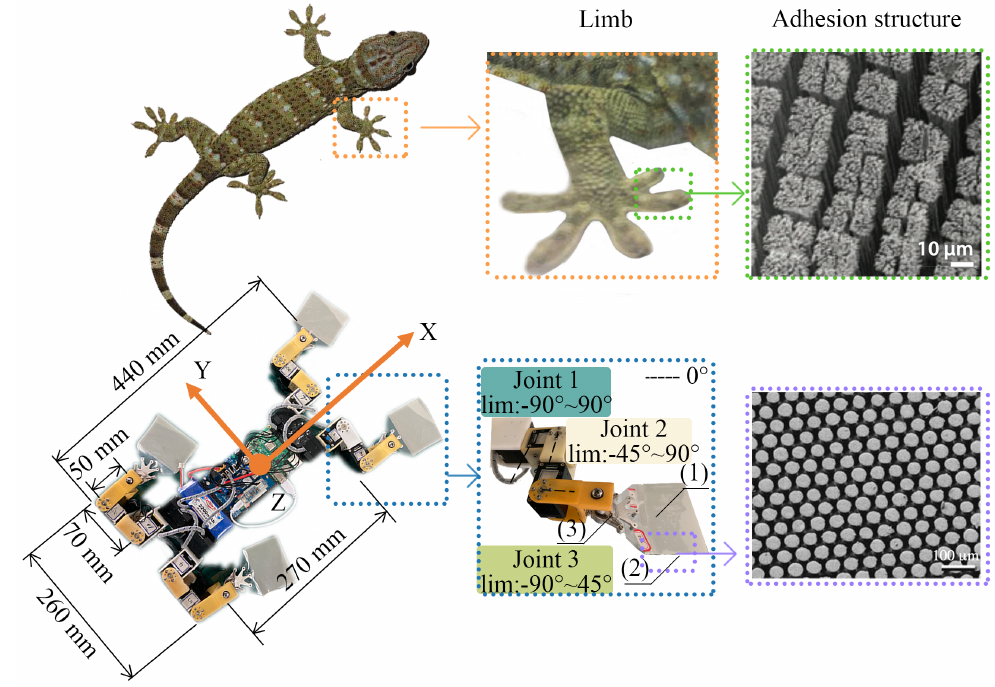
Figure 3. Bionic structure design of IBSS–8 for the body, limb, and adhesion unit. The workspace limitation and 0° position of each joint can be checked. A gecko’s adhesion unit is the bristles of the sole, and that of the robot is PVS [5]. (1) Upper surface of adhesive (PVC). (2) Gecko-like adhesive material (PVS). (3) Passive ball bearing and reset